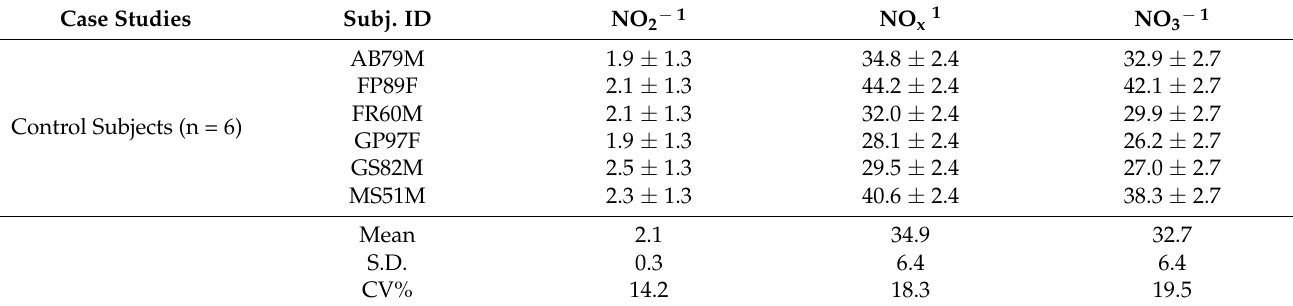
Table 4. Nitrite and nitrate concentration in plasma of volunteer